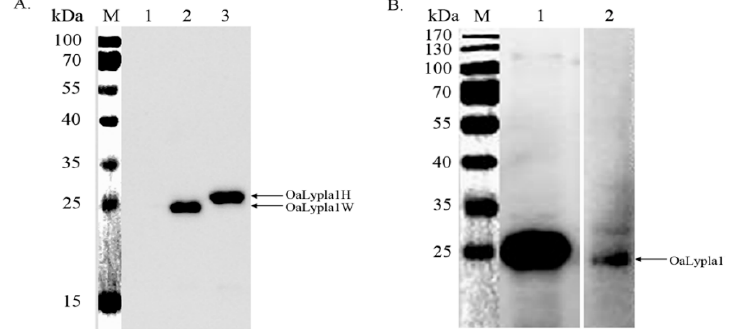
Figure 6. Immunoassay specificity of the monoclonal antibody against OaLypla1. ( A ) Immunoassay specificity against the recombinant OaLypla1. M: protein marker (Thermo, Waltham, MA, USA); lane 1 : total proteins from the uninduced pET-30a-LYPLA1-W cells; lane 2 : total proteins from the induced pET-30a-LYPLA1-W cells; lane 3 : total proteins from the induced pET-30a-LYPLA1-H cells; ( B ) Immunoassay specificity against the native OaLypla1. M: protein marker (Thermo, Waltham, MA, USA); lane 1 : total proteins from the induced pET-30a-LYPLA1-H cells as a positive control; lane 2 : total proteins extracted from the kidney of O. aries . The pET-30a-LYPLA1-W cells were induced to express the recombinant OaLypla1 with no His 6 -tag, and the pET-30a-LYPLA1-H cells expressed OaLypla1 fused with a His 6